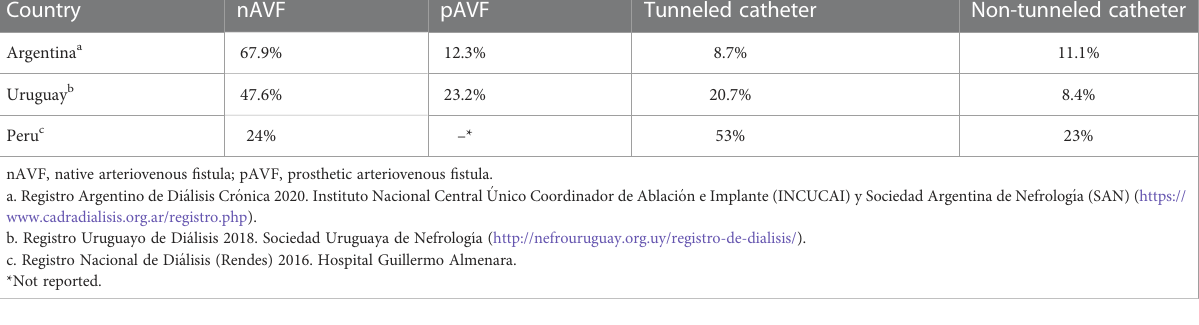
TABLE 1 Epidemiology of vascular access in prevalent dialysis patients in Latin-America. Country Tunneled